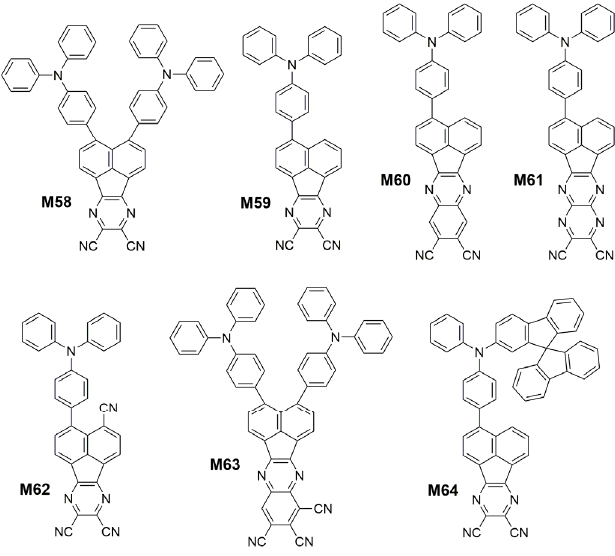
Figure 19. Chemical structures of M58 to M64 .